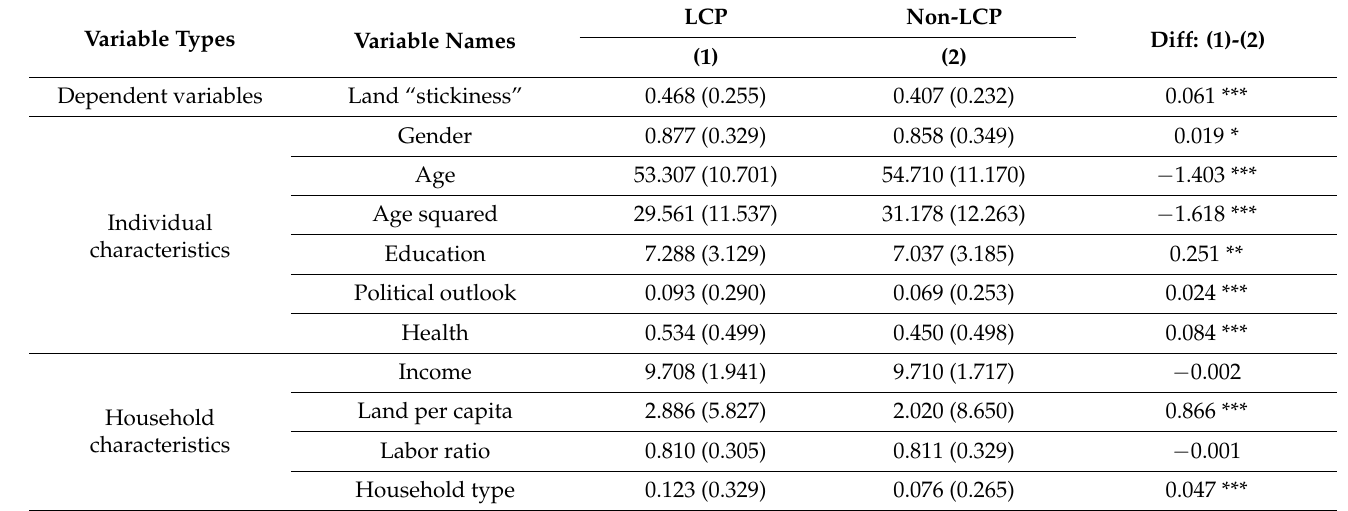
Table 2. Average individual, household, and village characteristics by LCP